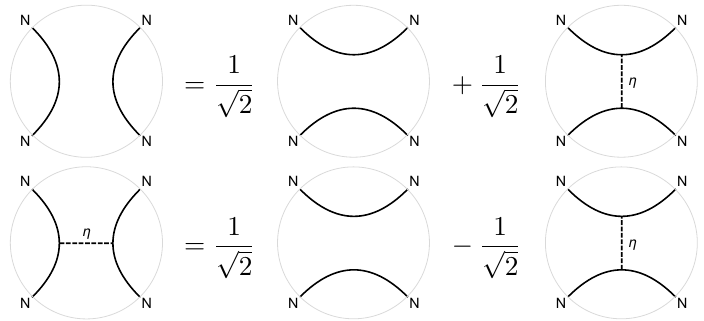
Figure 28 . The H-junction crossing relations involving the TDL N .